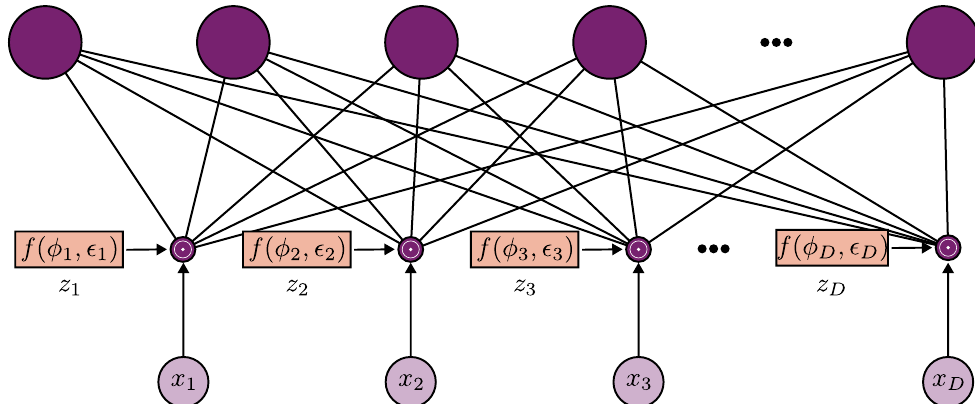
Figure 1. Dropout as a feature selection method. The variational parameter φ d , where d ∈ [ 1 .. D ] , controls the probability of the input feature x d to be dropped out, that is, an estimate of the noise level of x d . The variational parameters are used for feature